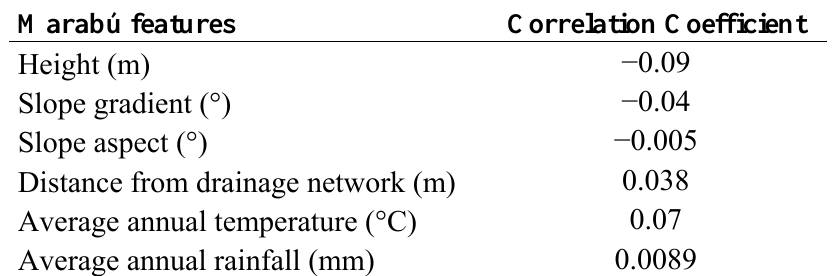
Table 5. Biserial correlation coefficient of the relationship between Marabú and natural components.